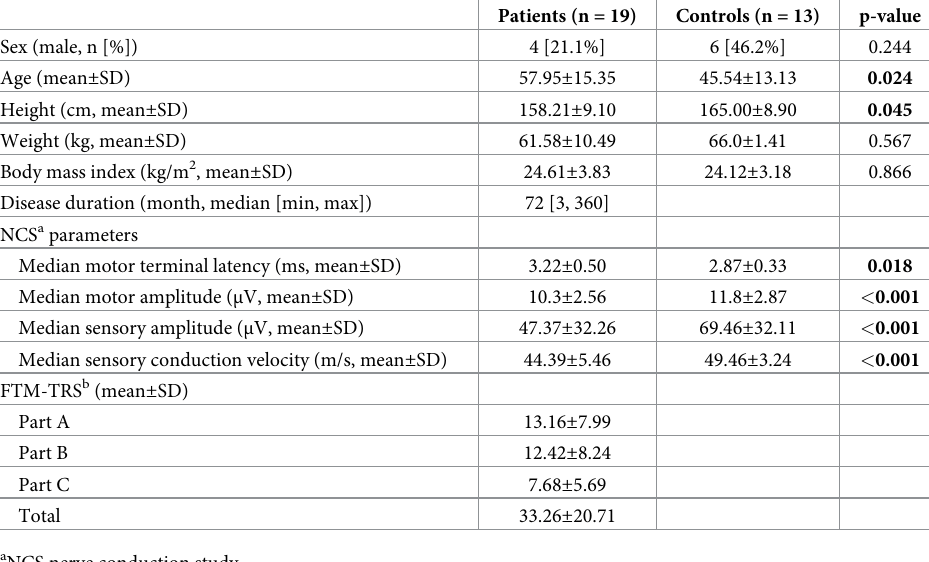
Table 1. Clinical characteristics and NCS parameters of patients and